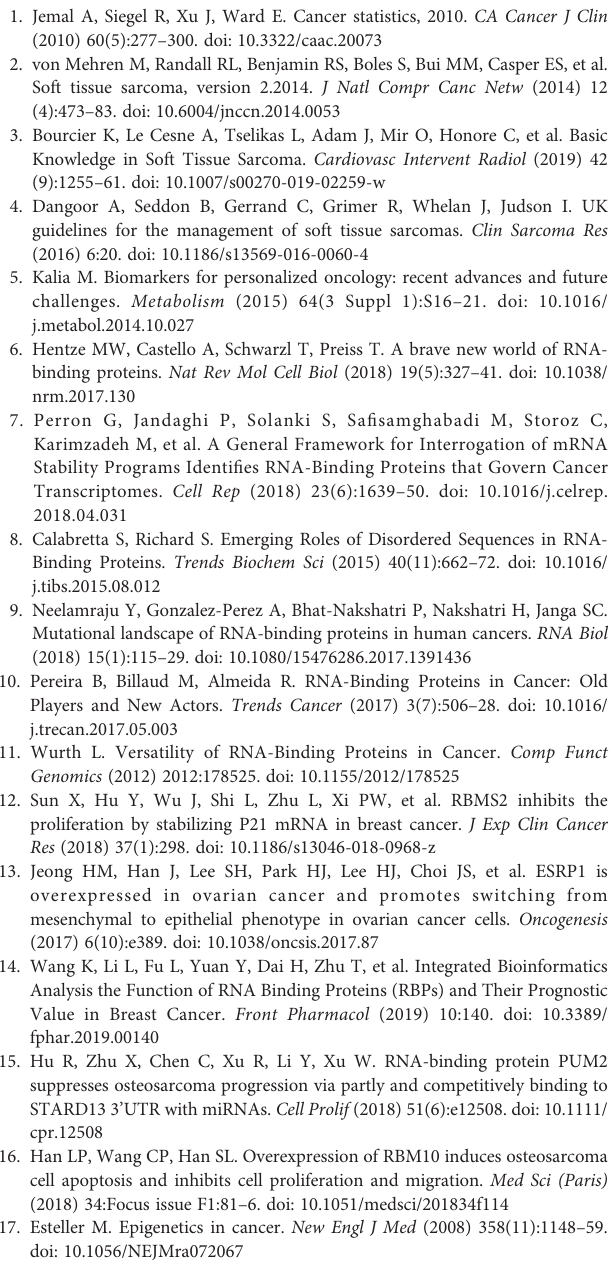
Supplementary File 3 | Detailed information of 329 RBPs. Note: 272 shared genes between the PPI network and 329 differentially expressed RBPs were marked with red color. Supplementary File 4 | The interactions of nodes in PPI network. Supplementary File 5 | The centrality indexes of nodes in PPI